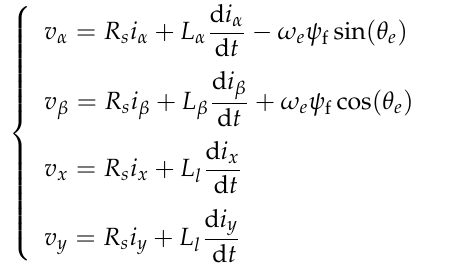
inductances of the α - and β -axes; L l is leakage induction, and L α = L β = L l + 3 L m ( L m is self-inductance); ω e is the rotor electric angular velocity; θ e is the electrical angle of the rotor relative to the phase A axis in the counterclockwise direction; ψ f is the rotor permanent magnet flux linkage; and R s is the stator